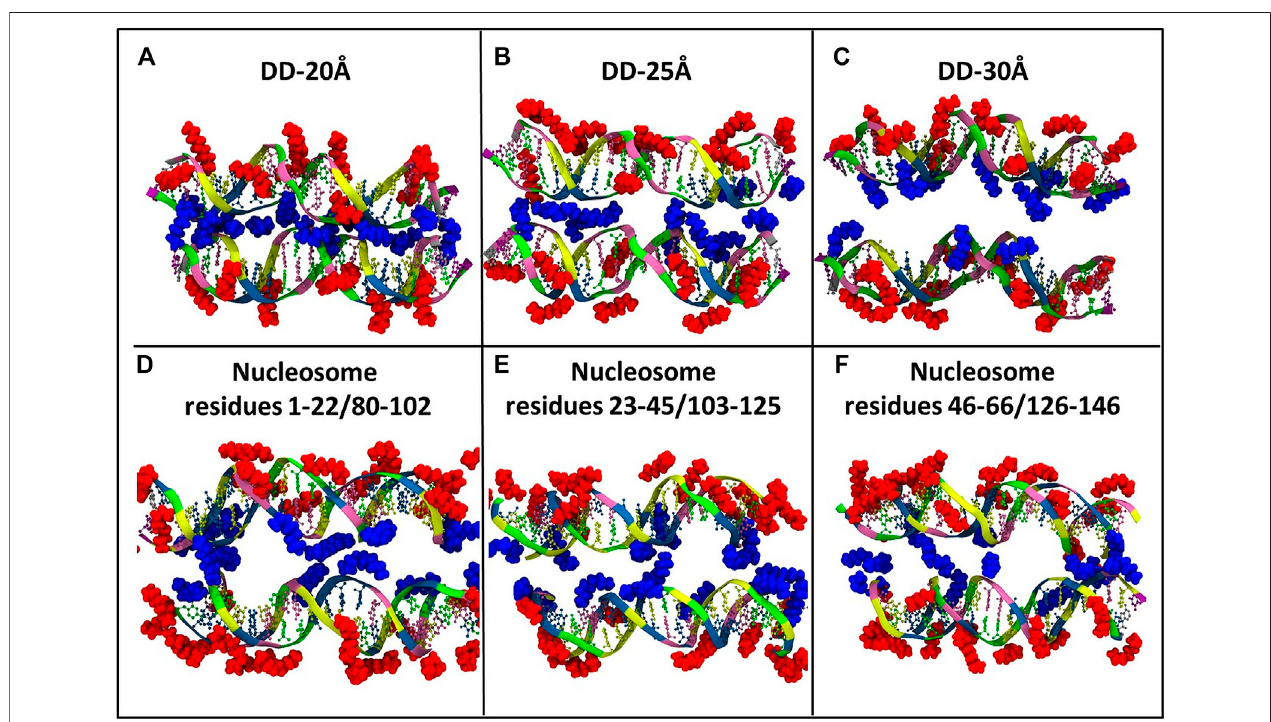
FIGURE 6 | Representative snapshots of the distribution of Spd 3+ around the two DNA molecules of each system (A) DD-20Å, (B) DD-25Å, (C) DD-30Å, and around the nucleosomal DNA (D – F) . To facilitate the visual comparison, the section of the nucleosome system that contains the DNA1 and DNA2 segments was split in three parts with lengths similar tothe DDsystems. Water and ions are omitted for clarity. Spd 3+ molecules are colored blue if located in the space between the two DNA molecules (caged), and red if located elsewhere (uncaged).